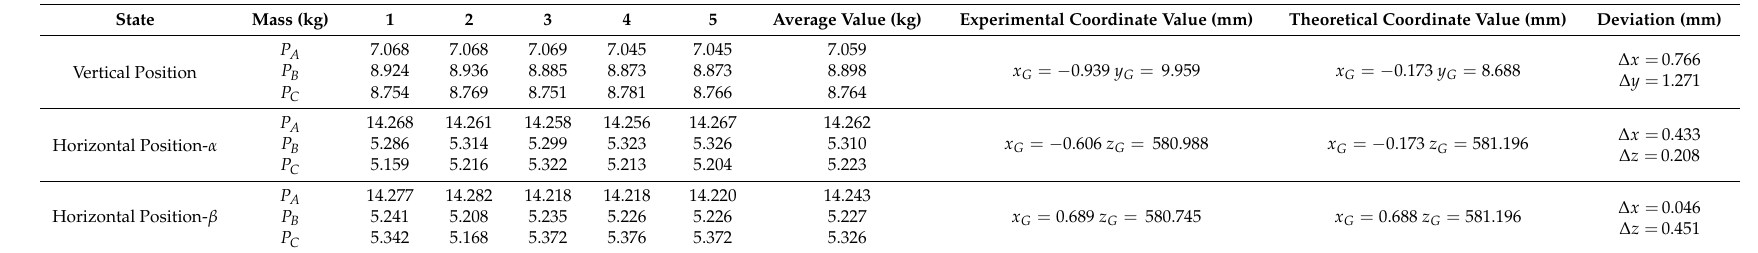
Table 13. The centroid measurement results of the